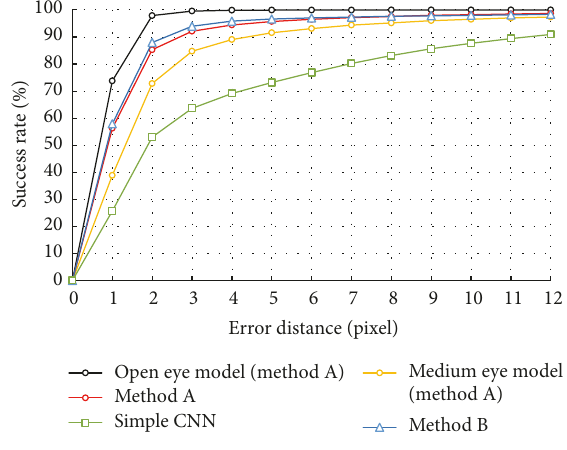
Figure 11: Performance